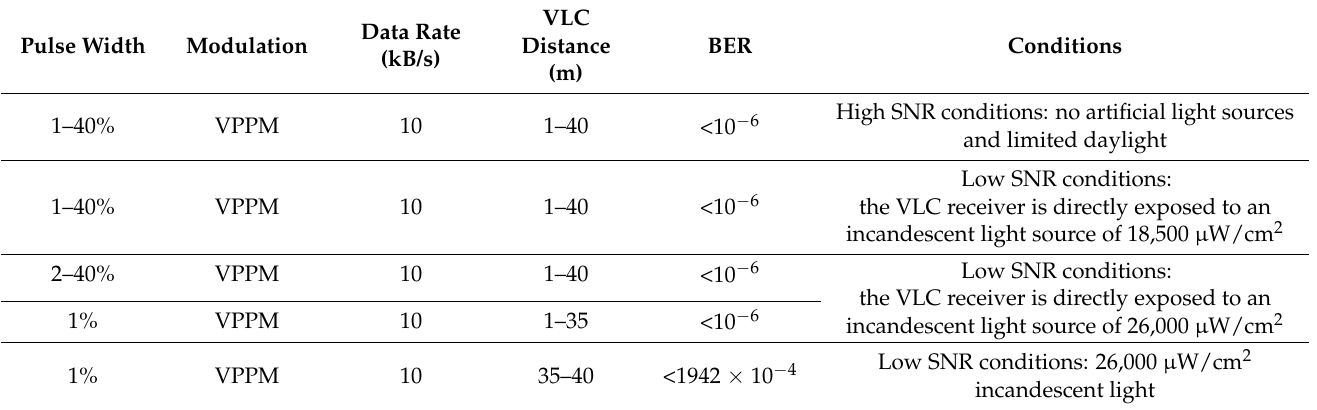
Table 7. Summary of the experimental results for the indoor